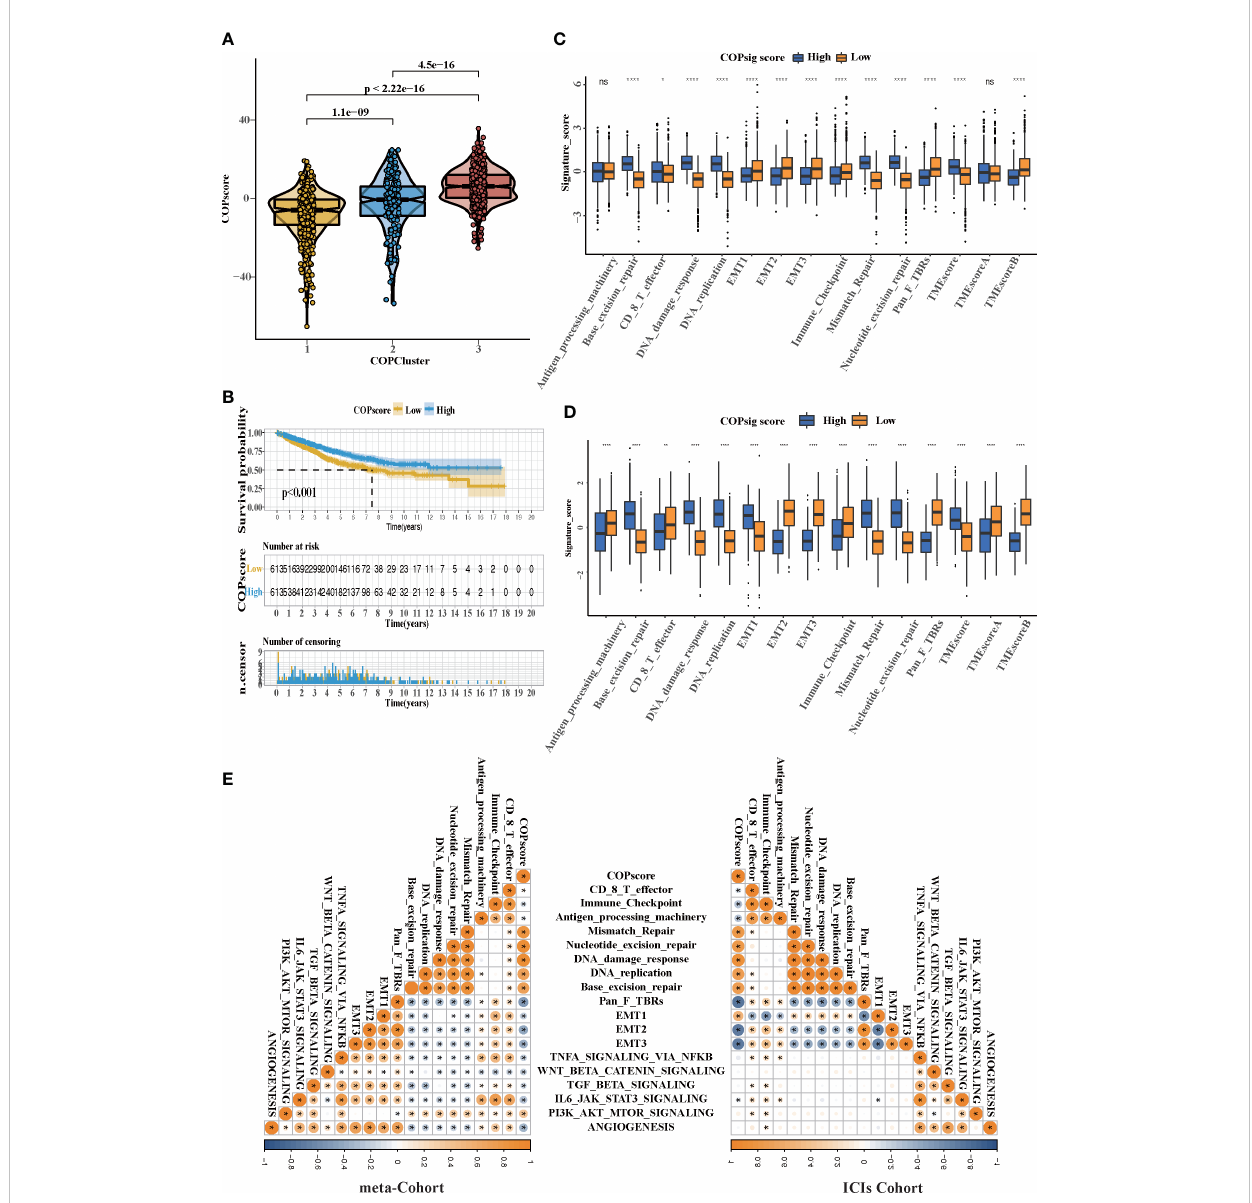
FIGURE 5 The TME cell in fi ltration characteristics in the high and low COPsig score groups. (A) Differences in COPsig score among three COPclusters in the meta-cohort. The Kruskal – Wallis test was used to compare the statistical difference between three gene clusters ( p < 0.001). (B) Kaplan – Meier curves for the two COPsig score groups, including 789 samples in the high COPsig score group, and 437 samples in the low COPsig score group (log-rank test). The high COPsig score group showed a signi fi cant better prognosis. (C) The fraction of TME cell in fi ltration of the high and low COPsig score groups using the ssGSEA algorithm. The top end, median line, and bottom end of the box represent the 25%, 50%, and 75% values, respectively. The black dots show outliers. The asterisks illustrate the statistical p -value (* p < 0.05, ** p < 0.01, *** p < 0.001, **** p < 0.0001, ns p > 0.05). (D) The fraction of different signatures (immune-relevant signature, mismatch-relevant signature, and stromal-relevant signature) and TMEscore. The line in the box represents the median value. The bottom and top of the boxes are the 25th and 75th percentiles (interquartile range). The whiskers encompass 1.5 times the interquartile range. The asterisks illustrate the statistical p -value (* p < 0.05, ** p < 0.01, *** p < 0.001, **** p < 0.0001, ns p > 0.05). (E) Correlations between COPsig score and the known biological gene signatures in the meta-cohort and the ICI cohort using Spearman analysis. Negative correlation was marked with blue and positive correlation was marked with